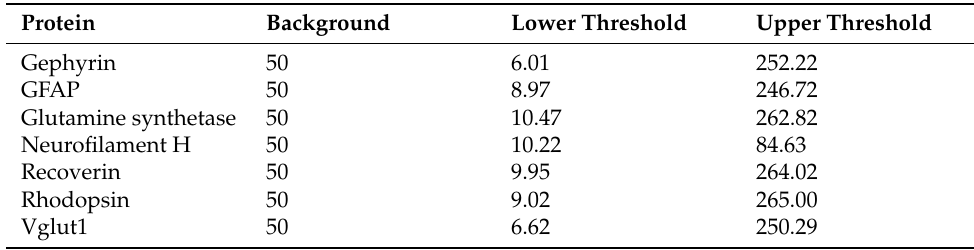
Table 2. Adjustments in ImageJ macro for area analysis. The background subtraction (pixel) as well as the lower and the upper thresholds are listed.